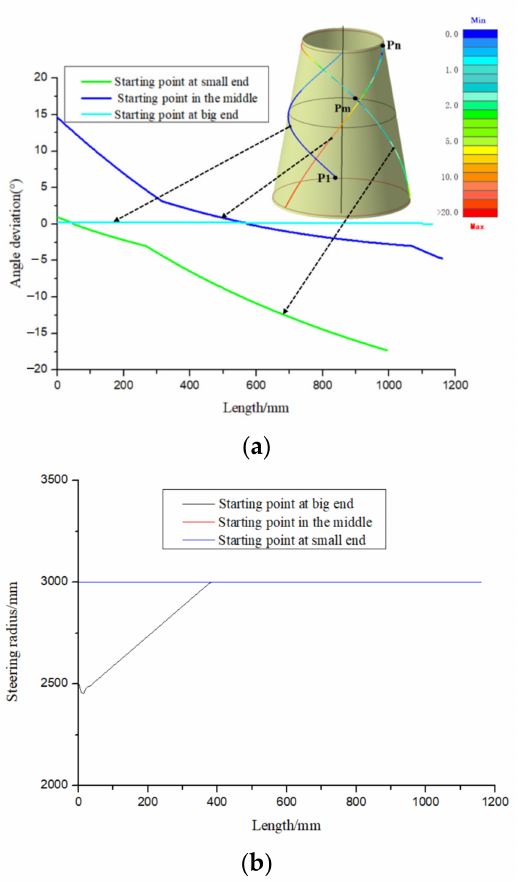
Figure 6. Paths on conical shells surface and its manufacturability. ( a ) Paths and Angle deviation evaluation. ( b ) Fiber steering